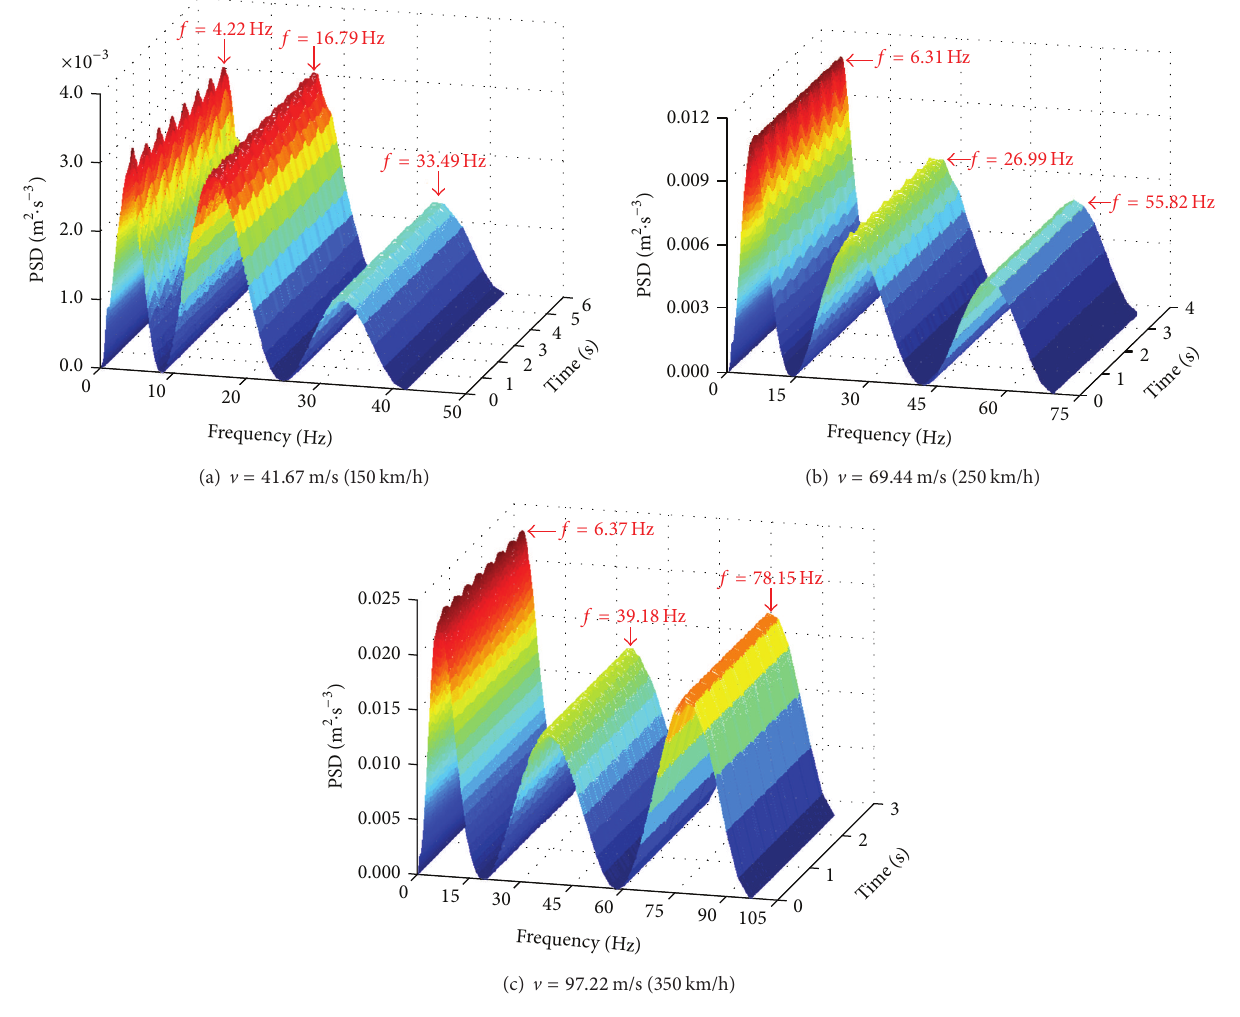
Figure 23: PSD of vertical acceleration of motor car rear